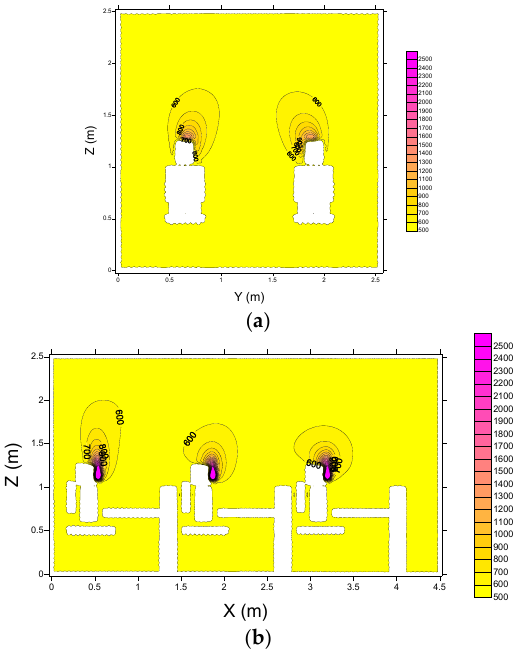
Figure 12. CO 2 concentration field in the virtual classroom with 6 occupants in the plans ( a ) X = 1.791 m and ( b ) Y = 0.63099 m, with an inlet air temperature of 20 °C.